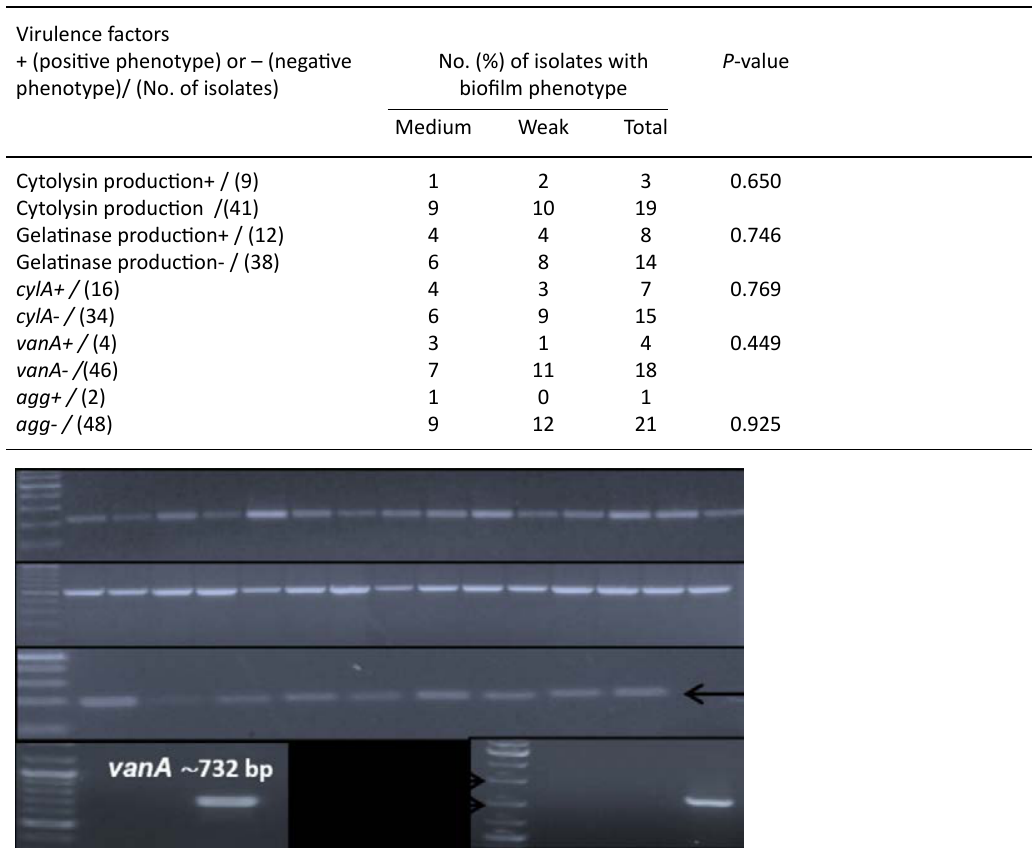
Table 4. Correlation between the phenotypic and genotypic presence of virulence factors, vancomycin resistance gene and biofilm formation